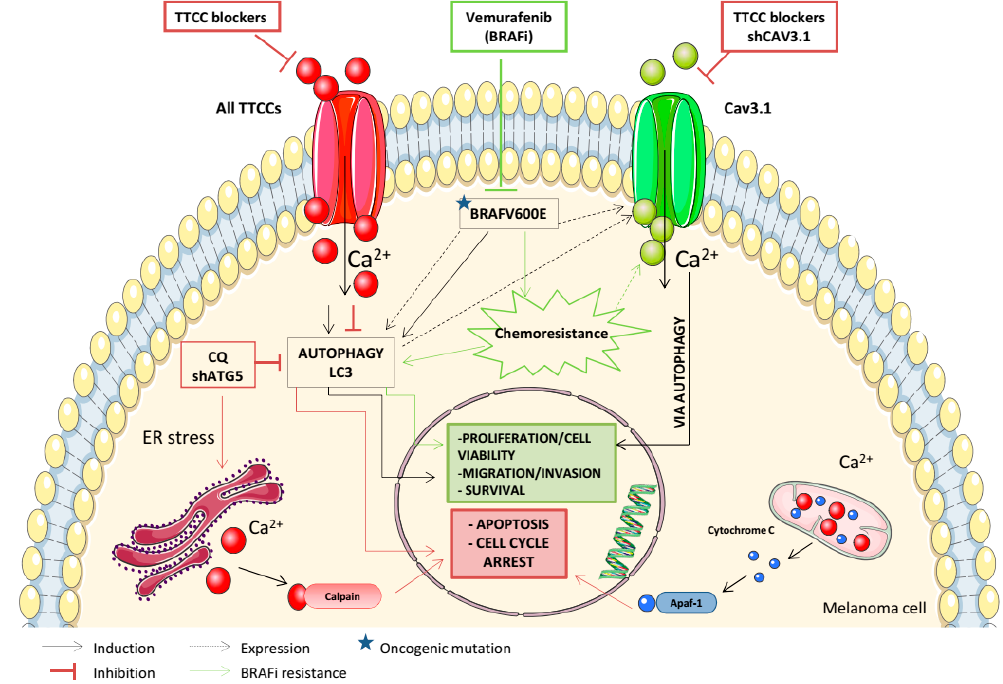
Figure 2. TTCCs play a significant role in cellular proliferation, apoptosis, migration, autophagy, and acquisition of BRAFi resistance in melanoma. The figure represents the relationships identified in different studies between TTCC expression and autophagy, and the effects of TTCC blockers in melanoma cells.